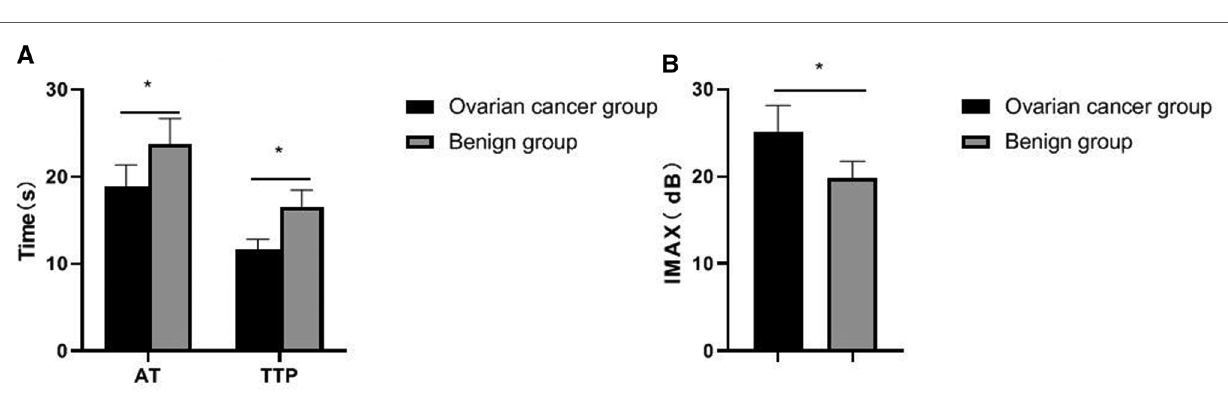
FIGURE 4 | Comparison of contrast-enhanced ultrasound parameters between the two groups. ( A ) AT and TTP; ( B )